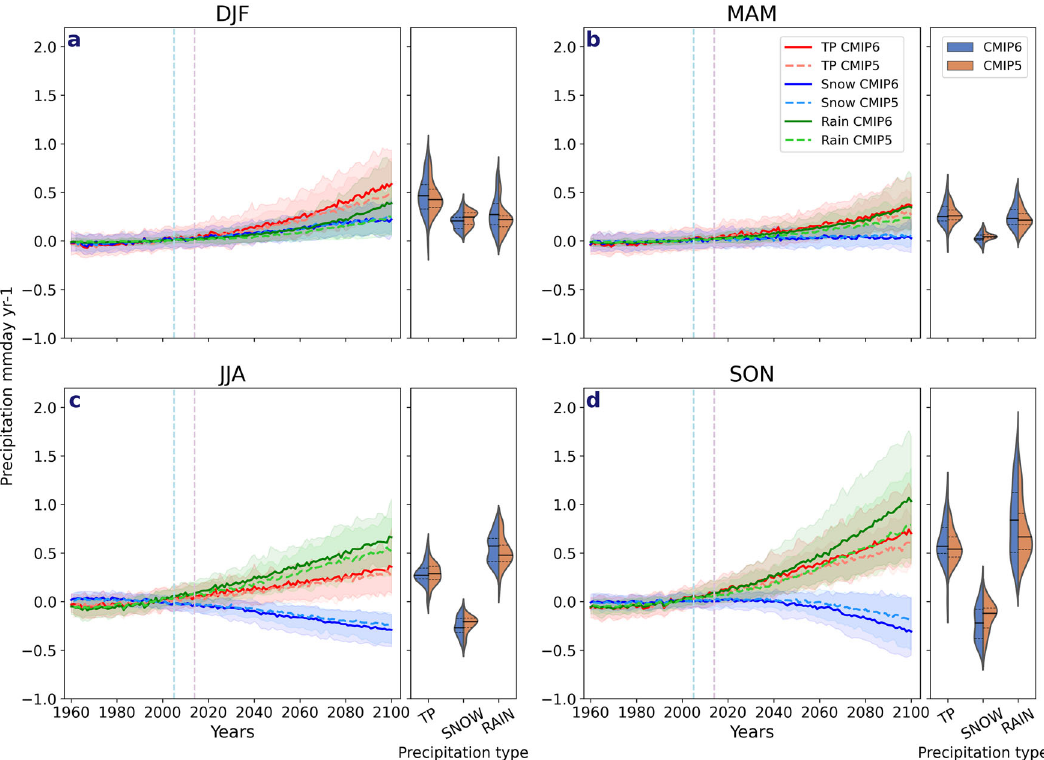
Fig. 2 Time series of total precipitation, snowfall and rainfall anomalies. Changes in total precipitation (TP) (red, orange), snowfall (snow) (blue, light blue) and rainfall (rain) (green, light green) in CMIP6 and CMIP5 are shown relative to the 1981 – 2009 climatological mean for a December – February (DJF), b March – May (MAM), c June – August (JJA) and d September – November (SON). The light blue vertical dashed line denotes when the historical period for CMIP5 ends and the light purple vertical dashed line denotes when the historical period of CMIP6 ends and thereafter the RCP8.5 and SSP5 – 8.5 climate scenarios for CMIP5 and CMIP6 are used. The shading around each line highlights the spread based upon the lower 5th and 95th percentiles among the model members. The violin plots represent the model spread from 2090 to 2100 for each total precipitation (TP), snowfall (snow) and rainfall (rain) with the dashed black lines representing the 25th and 75th percentiles, and the black vertical line representing the mean of all